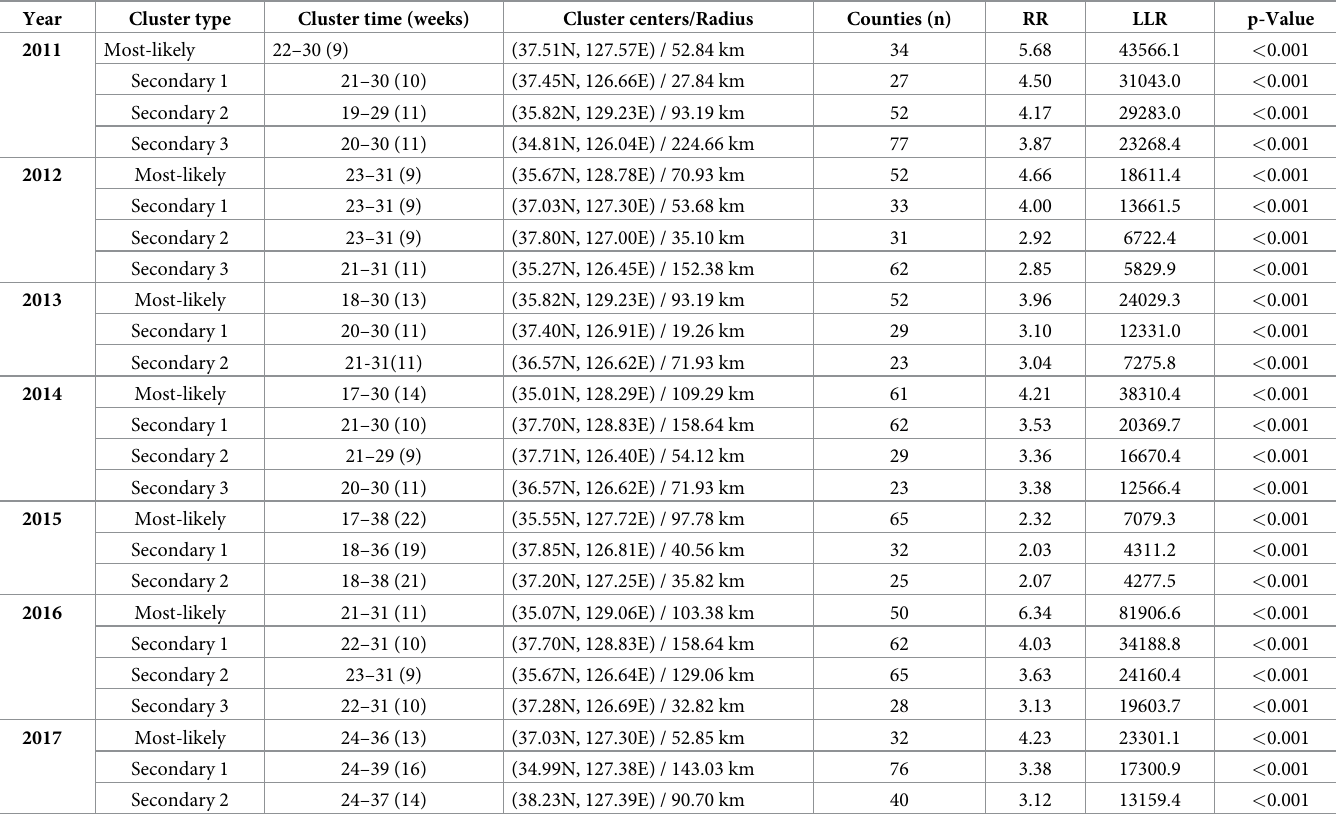
Table 3. Results of the space-time cluster at the district level,